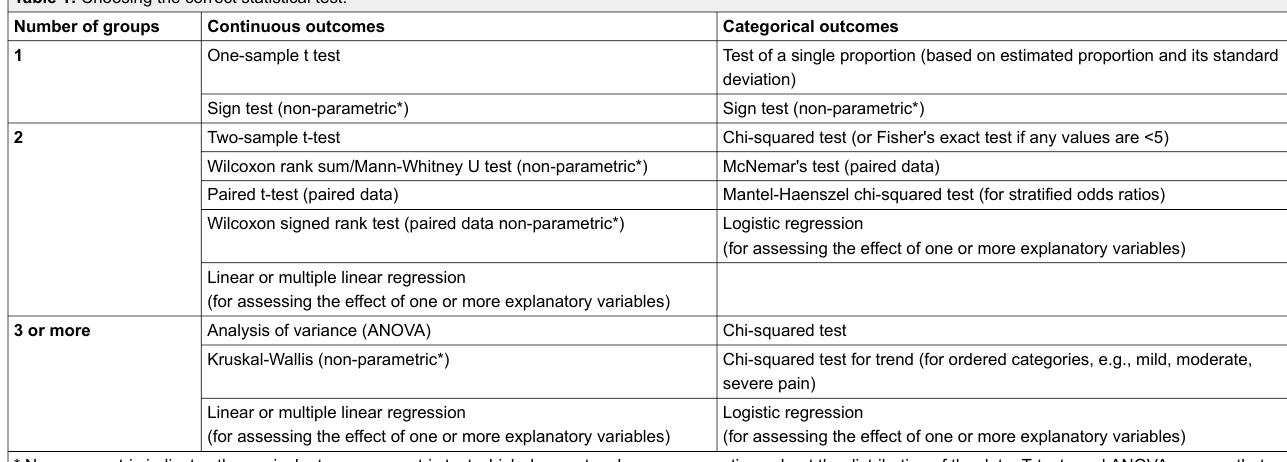
Table 1: Choosing the correct statistical test. Number of